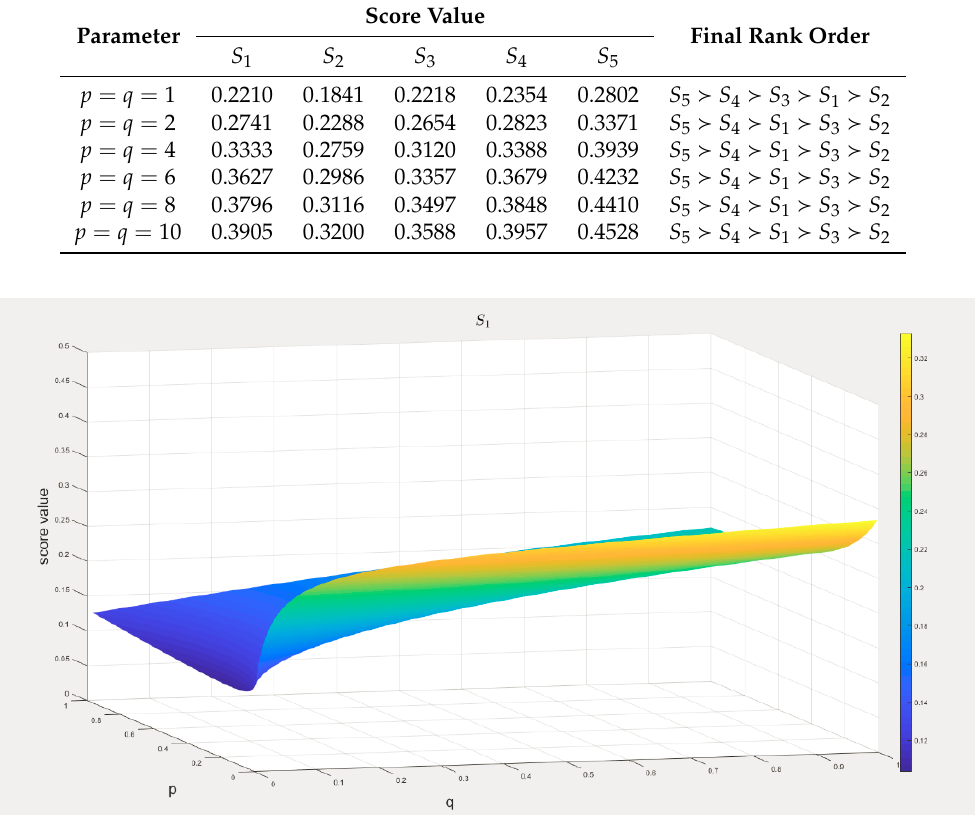
S with , [0,1] p q  . Figure 2. Values of Figure 2. Values of Figure 2. Values of S 1 with p , q ∈ [ 0,1 ] . 1